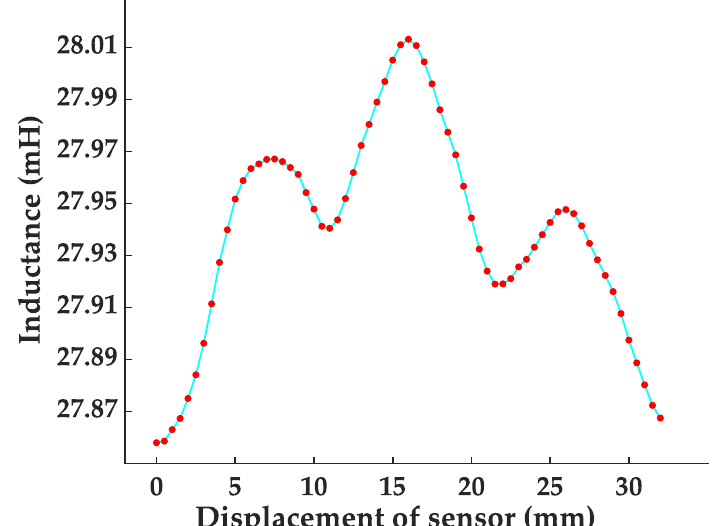
Figure 5. Inductance values of grooves with different parameters scanned continuously by sensors.